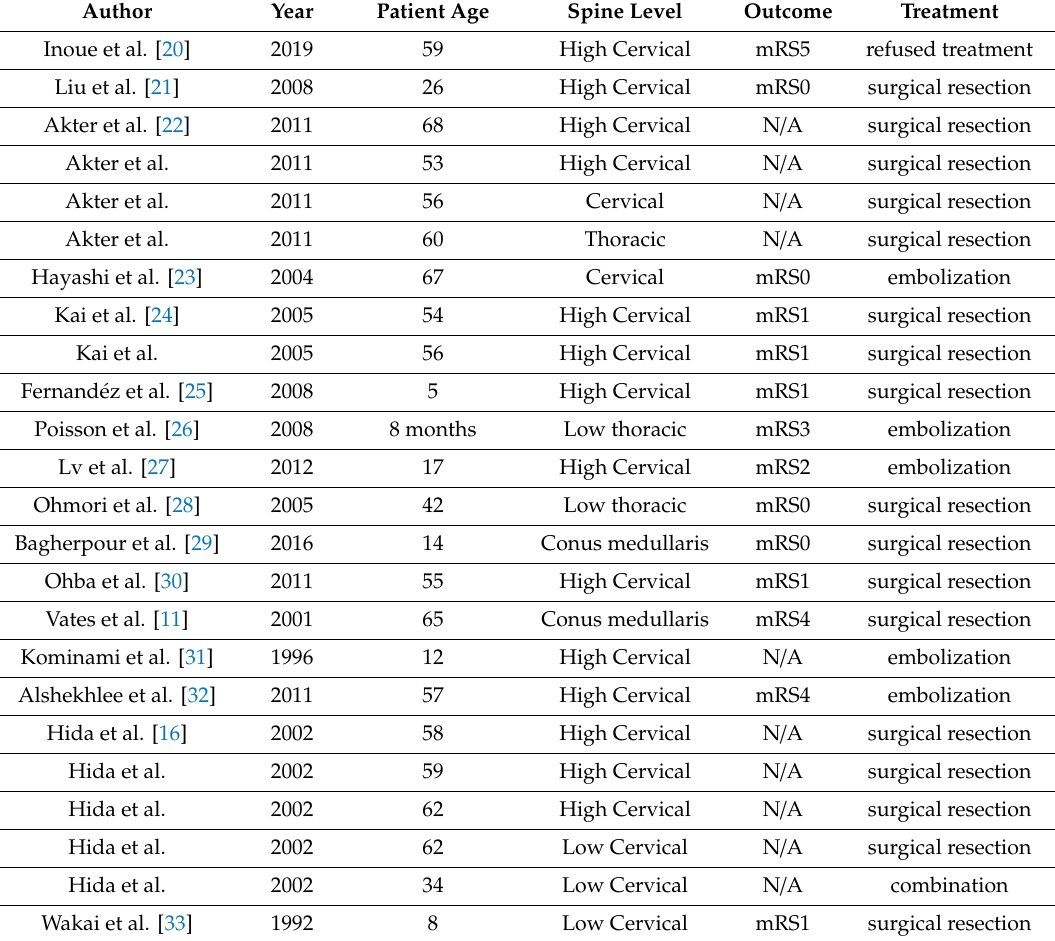
Table 1. Literature summary of spinal arterio-venous (AV) fistulas which presented with spontaneous subarachnoid hemorrhage